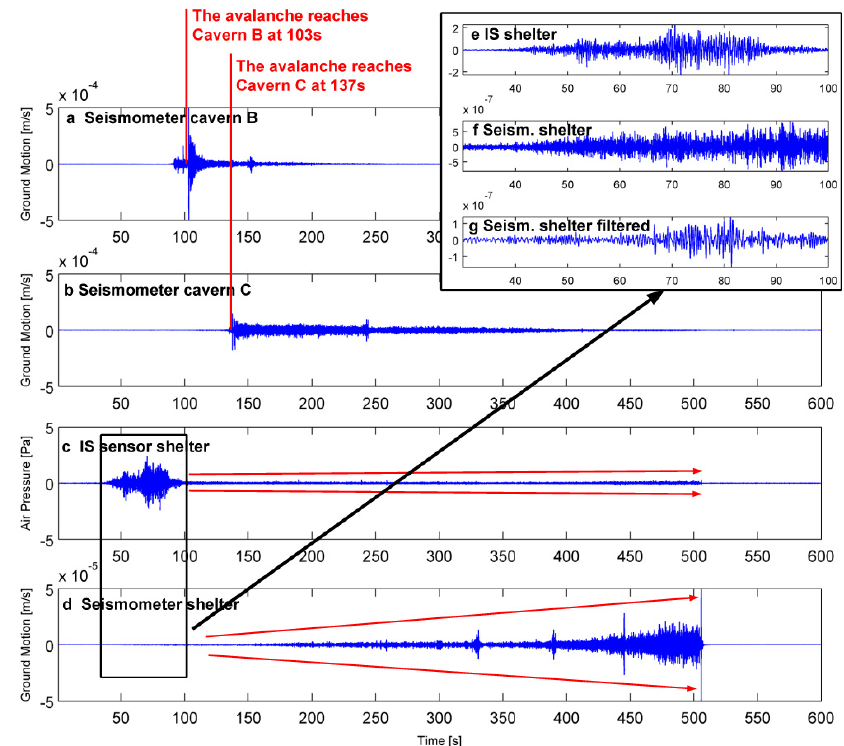
Fig. 15. Seismic (N-S component) and infrasonic data from Avalanche 4. Signals are represented with a common base of time. (a) Seismo- gram in cavern B; (b) Seismogram in cavern C; (c) infrasound time series near the shelter; (d) Seismogram in cavern B (red arrows indicate the infrasound signal associated with the different surges of the avalanche); (e) magnified infrasound time series; (f) magnified Seismogram near the shelter; (g) magnified Seismogram (1Hz to 3Hz) near the shelter. Note the similar spindle shape between the seismic (g) and infrasound signals (e) . Magnified time series are shown with a different scale of amplitude and all series are plotted on an arbitrary time